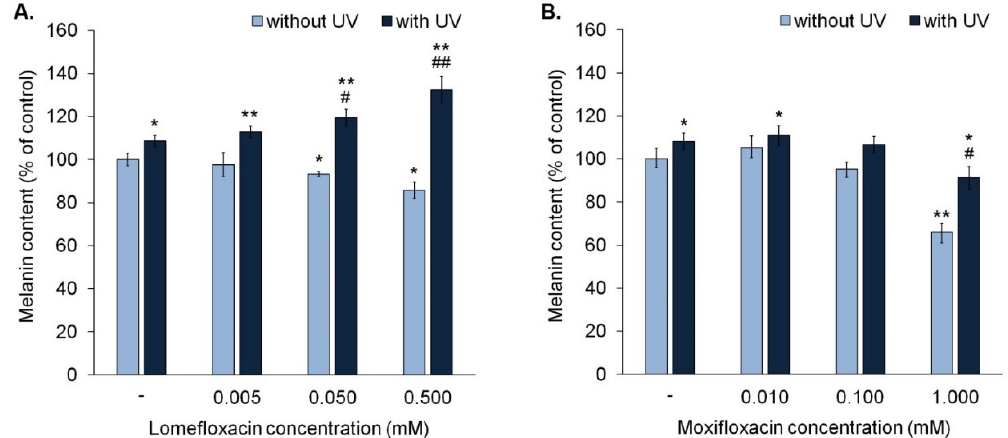
Figure 4. Fluoroquinolones alone decrease melanin content in melanocytes. Lomefloxacin potentiates the impact of UVA radiation (1.3 J/cm 2 ) on melanin content. The cells were exposed to lomefloxacin in concentrations of 0.005 mM, 0.05 mM, and 0.5 mM ( A ) and moxifloxacin in concentrations of 0.01 mM, 0.1 mM, and 1.0 mM ( B ). Data were presented as % of the control. Bar graph represents mean ± SD from three independent experiments. * p < 0.05, ** p < 0.01 vs. control; # p < 0.05, ## p < 0.01 vs. non-treated cells exposed to UVA radiation.